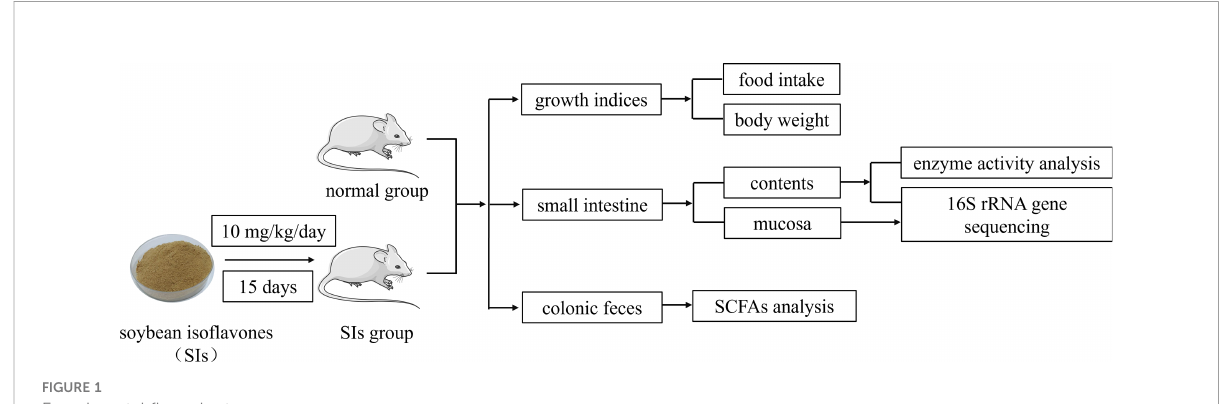
FIGURE 1 Experimental fl ow